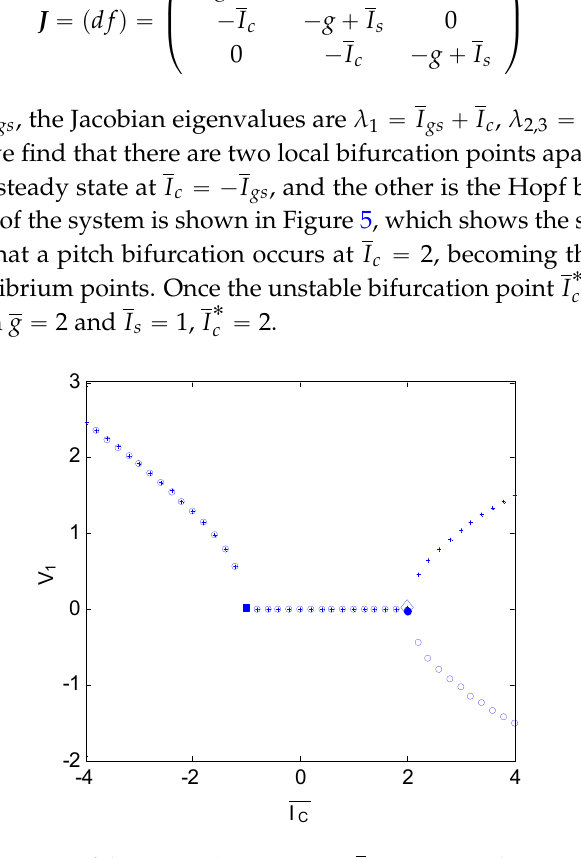
Figure 5. Bifurcation diagram of the system ( N “ 3, g “ 2, I s “ 1). Once the unstable bifurcation point is reached, the system begins to oscillate. Solid dots indicate the unstable bifurcation point.